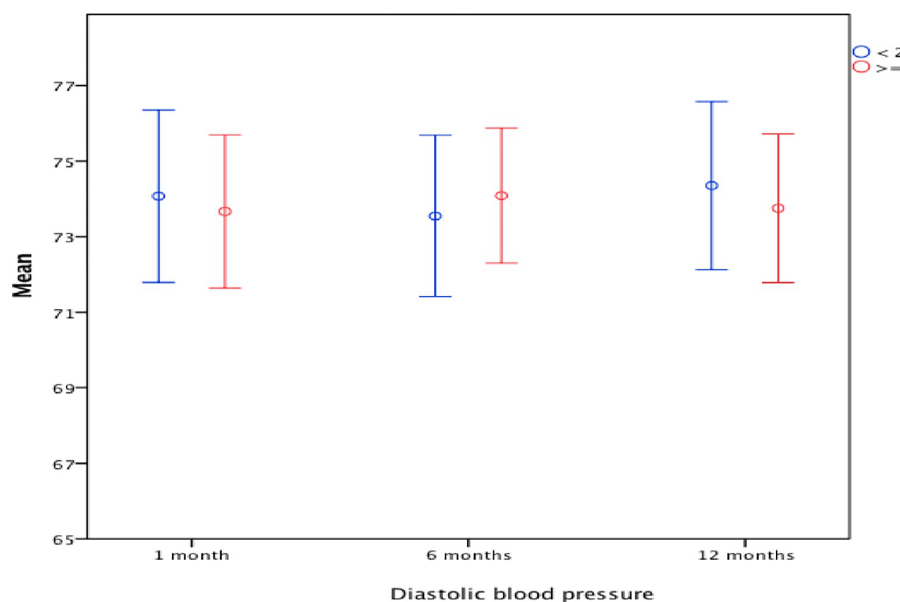
Fig 2. Mean and 95% confidence interval of the diastolic BP (mmHg) in the first year of the study in both groups (BMI < 2 vs. BMI > =